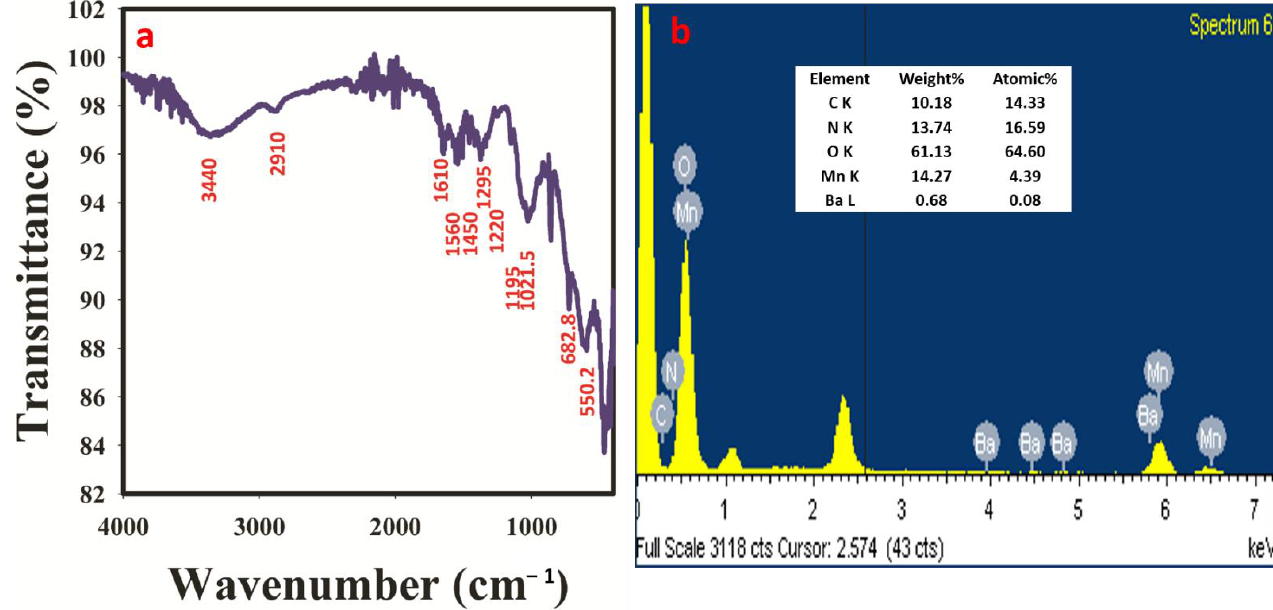
Figure 3. ( a ) FTIR spectrum of the synthesized PANI − MnBaO 2 composite. ( b ) XEDS spectrum of the PANI − MnBaO 2 composite.